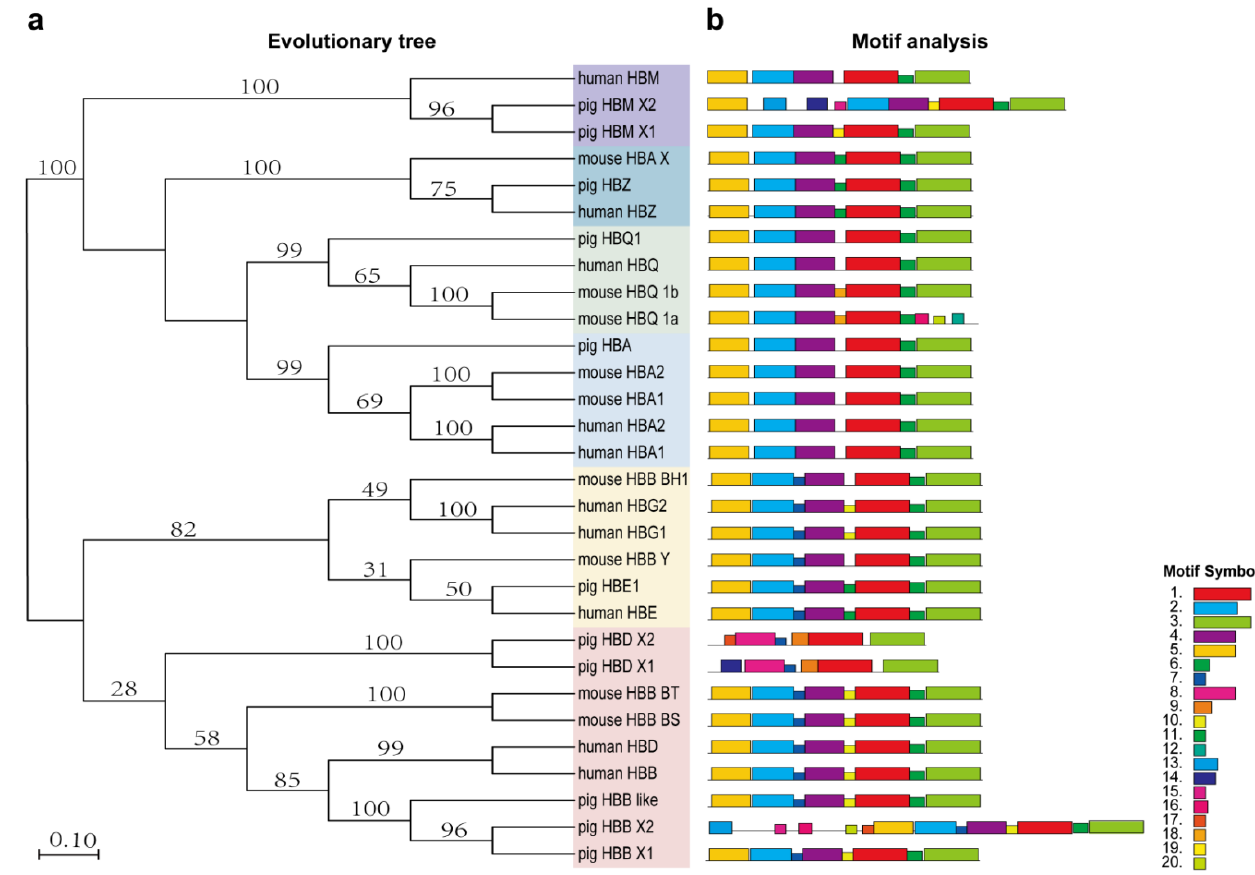
Figure 1. Phylogenetic relationships and motif composition of human, mouse and pig hemoglobin- encoding genes. ( a ) Represents the phylogenetic tree constructed by MEGA 5.0 software and different gene colors represent different clades; ( b ) represents the motifs constructed from human, mouse and pig protein sequences. Different colored boxes represent different motifs.